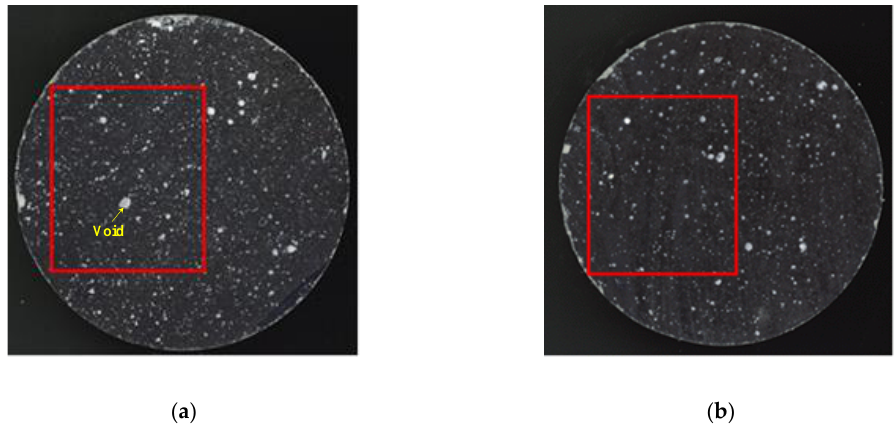
Figure 3. Evaluation of void distribution: ( a ) mortar; ( b ) matrix.